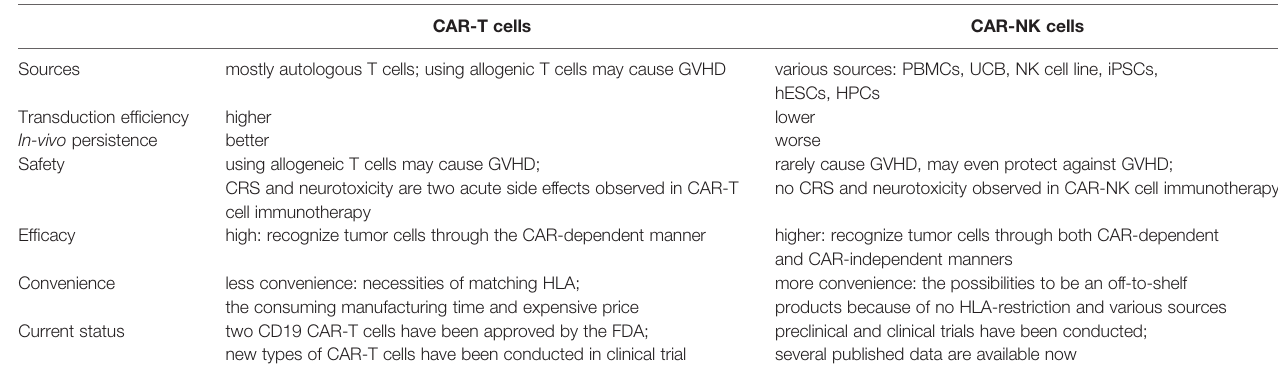
TABLE 2 | Comparisons between CAR-T cells and CAR-NK